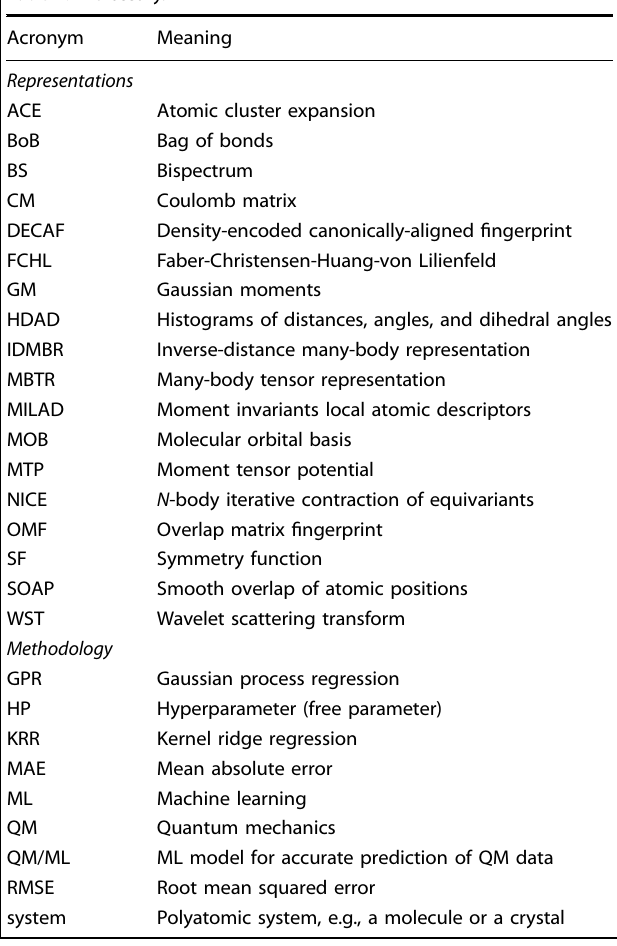
Fig. 1 Sketch illustrating the interpolation of quantum- mechanical simulations by machine learning. The horizontal axis represents chemical or materials space, the vertical axis the predicted property. Instead of conducting many computationally expensive ab initio simulations (solid line), machine learning (dashed line) interpolates between reference simulations (dots). Table 1. Glossary.